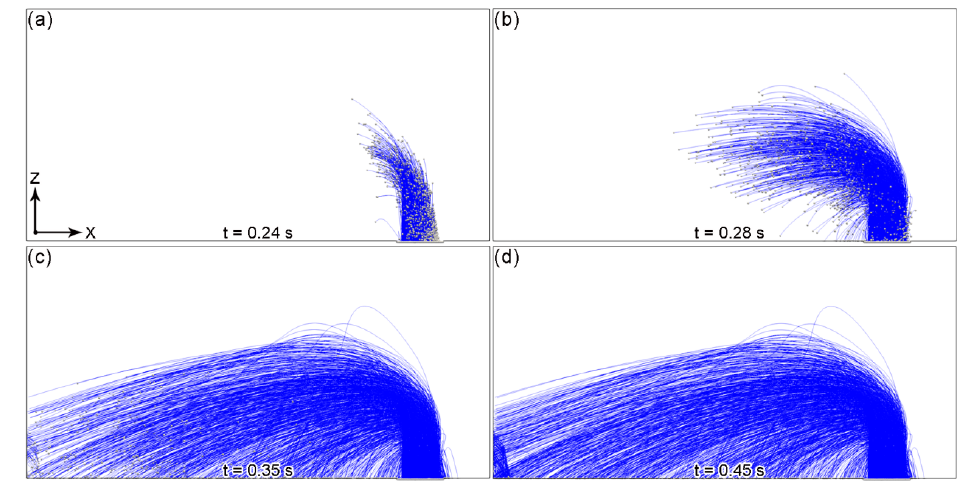
Figure 6. Spatter trajectory at different moments in Scheme B: ( a ) t = 0.24 s; ( b ) t = 0.28 s; ( c ) t = 0.35 s; ( d ) t = 0.45 s (the particles are enlarged 10 times to visualize the particle positions).